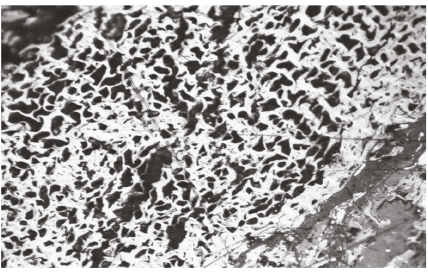
Figure 10: Morphology of fusinite under a